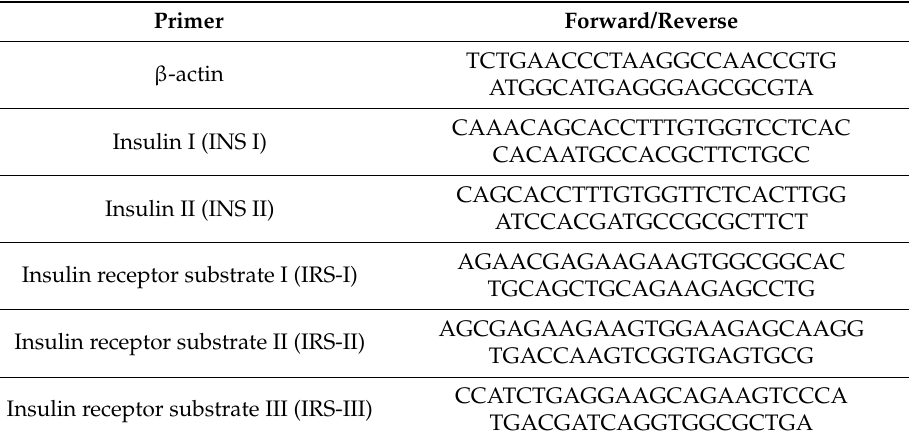
Table 2. Sequences of primer